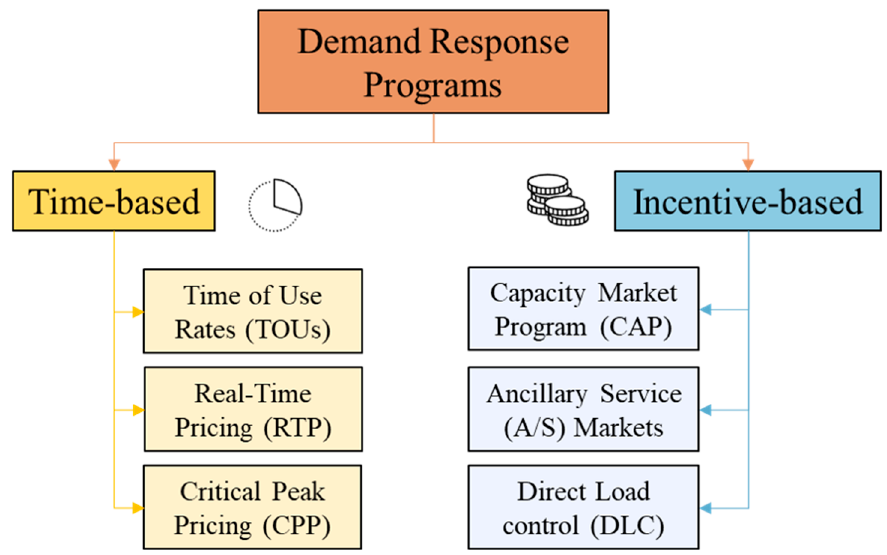
Figure 1. Demand response programs.